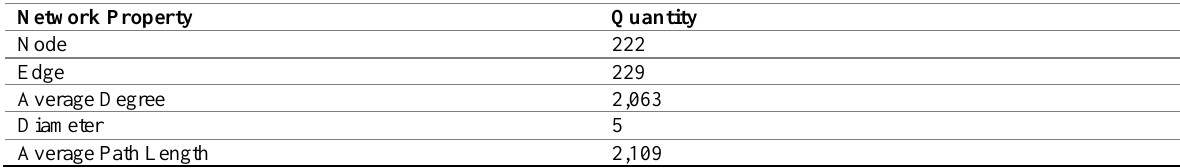
Table 3: OYO Social Network Properties